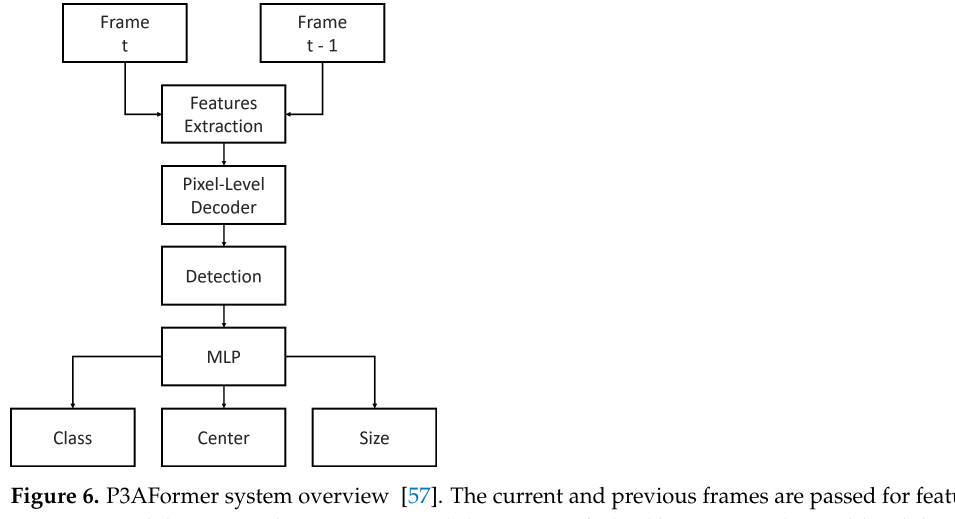
Figure 5. The hierarchical single-branch network proposed in Ref. [52]. The frames from a video source are passed into the network and outputs detections and tracks.